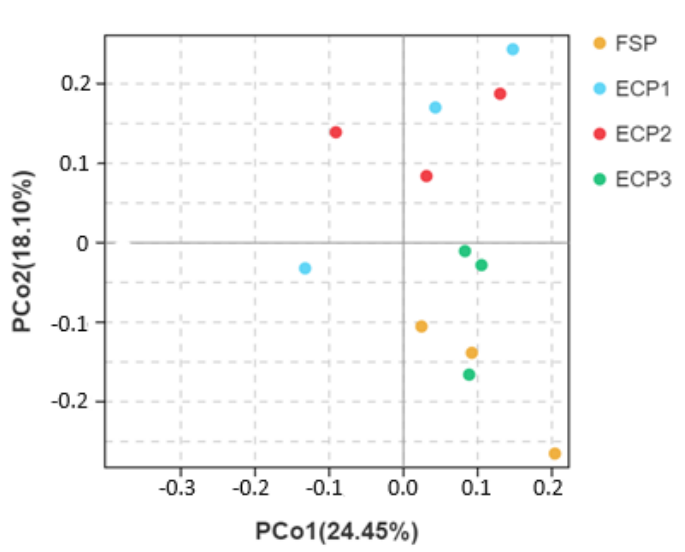
Figure 3. Principal coordinate analysis (PCoA) plot. The scatter plot is of principal coordinate 2 (PCo2) versus principal coordinate 1 (PCo1).